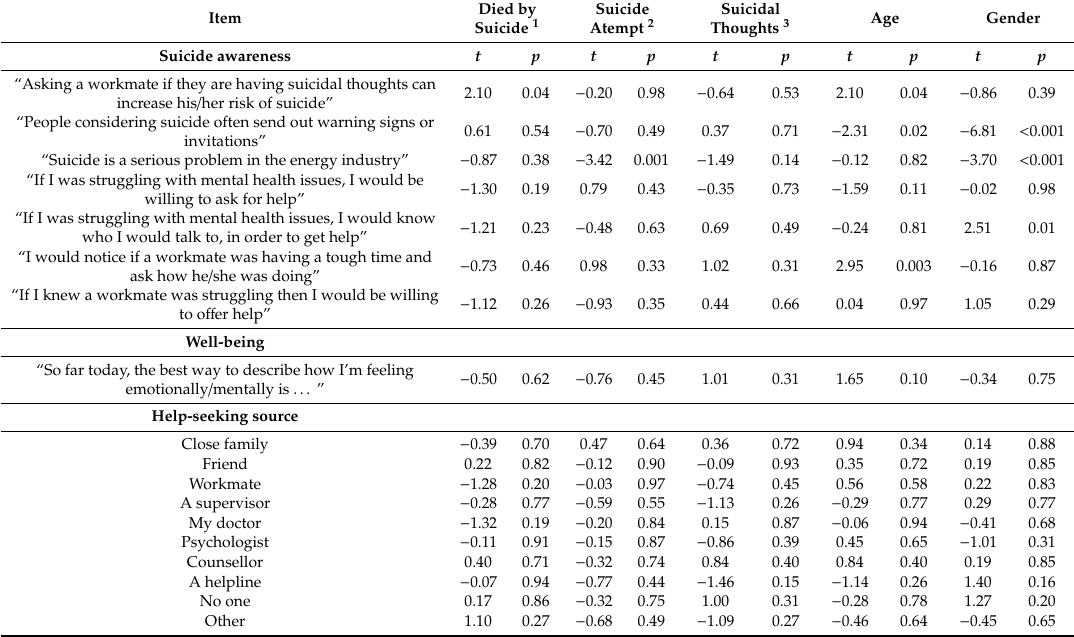
Table 3. Fixed e ff ect estimates for the predictors of change for GAT from the linear mixed e ff ects